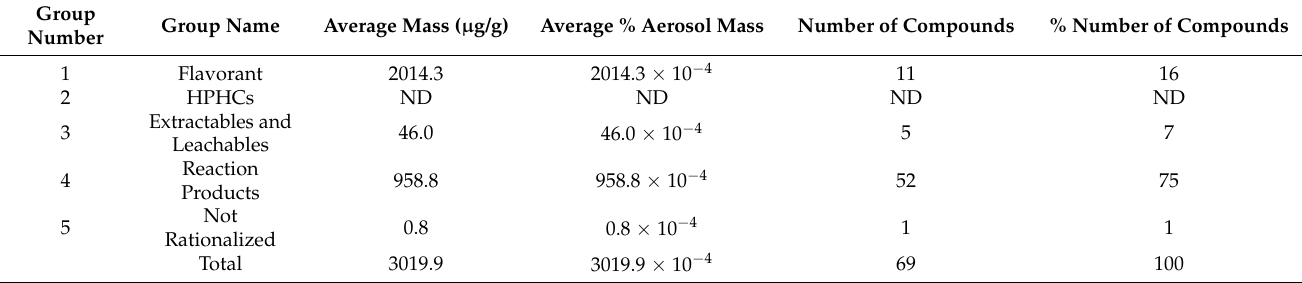
Table 6. Summary of Non-Targeted Analyses of VT3 Aerosol Using the Non-Intense Puffing